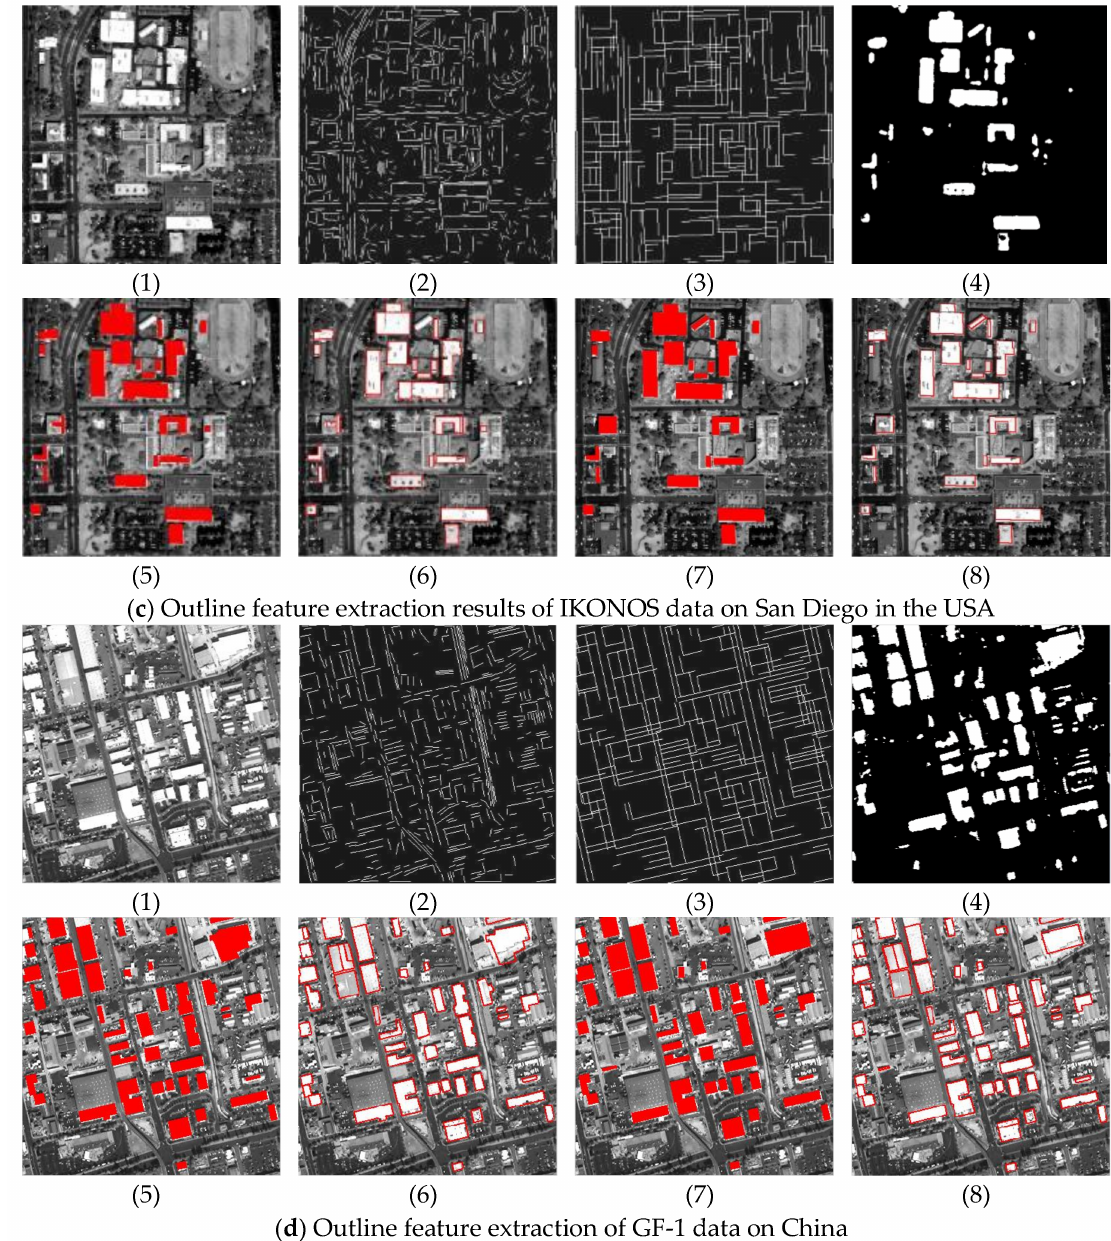
Figure 13. The results of outline extraction and contrast experiment. ( 1 ) the original satellite image, ( 2 ) the basic line extraction by LSD ( 3 ) the edge line feature by our correction method ( 4 ) the building extraction by segmentation method, ( 5 ) the building extraction by our method, ( 6 ) the outline feature by our method, ( 7 ) the building extraction by Wang’s method, ( 8 ) the outline feature by Wang’s